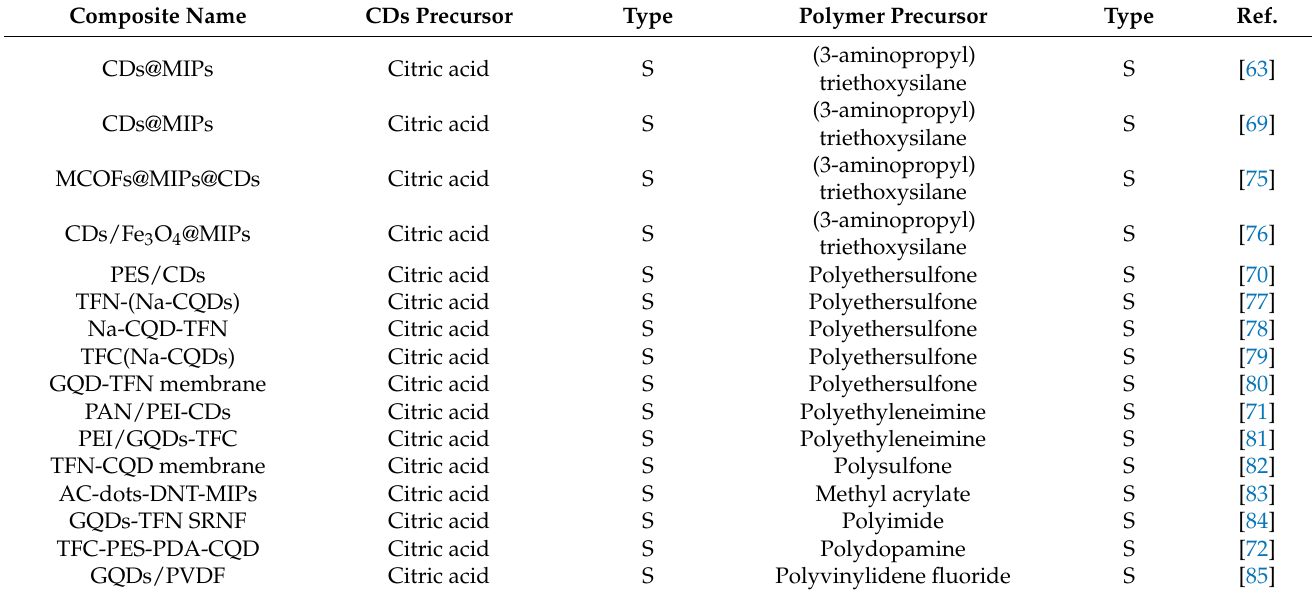
Table 1. Several precursors for the preparation of CD/polymer